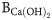
Hysteresis loops of (a) RH, (b) BCa(OH)2, and (c) C400,1 and C400,4.